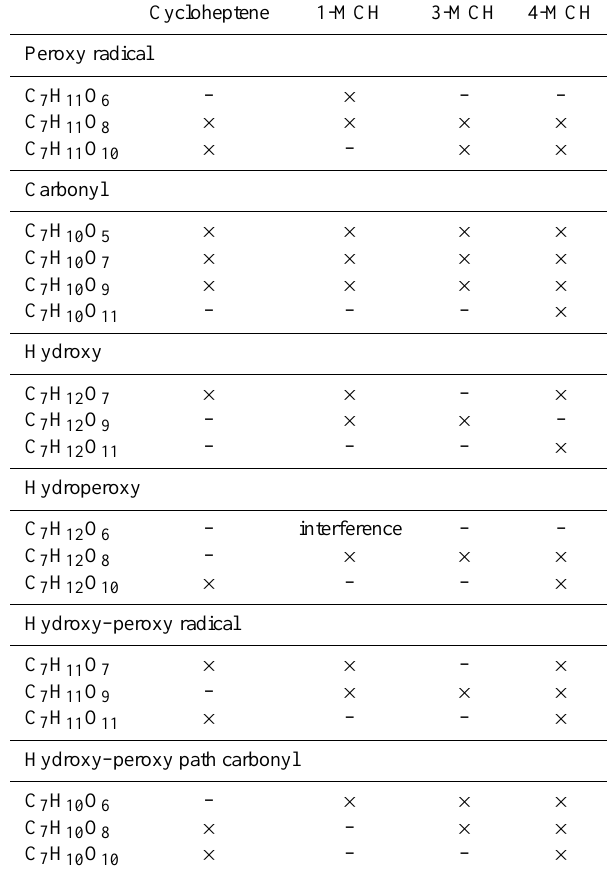
Table 11. Comparison of HOM products resulting from C 7 H 14